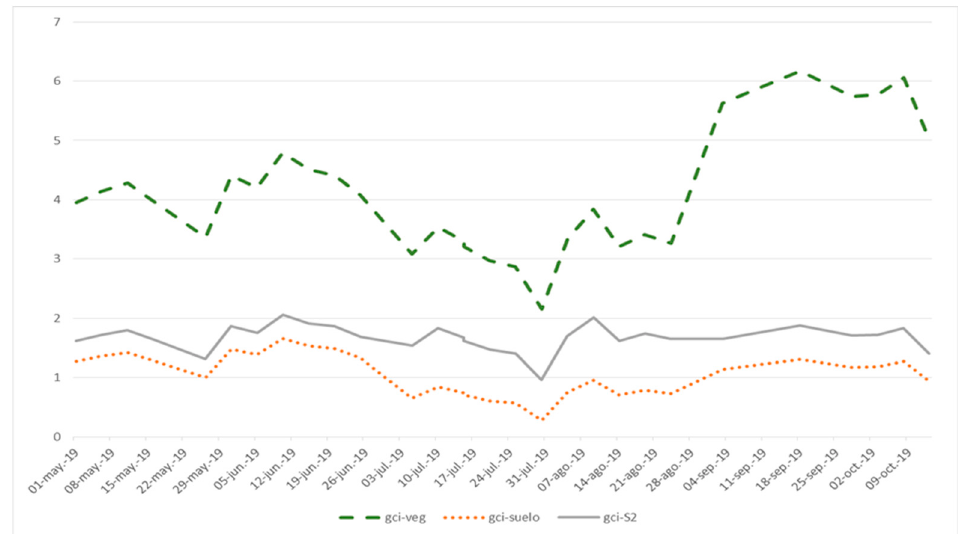
Figure 4 . Evolution of the NVDI and GNDVI spectral indices of a point associated with vegetation (green striped lines: ndvi-veg, gndvi-veg), of a point associated with soil (brown dotted lines: ndvi- soil gndvi-ground) and of the pixel in which these points are located in the Sentinel 2 images (gray continuous lines: ndvi-S2, gndvi-S2). Period: 1 May to 31 October 2019 .